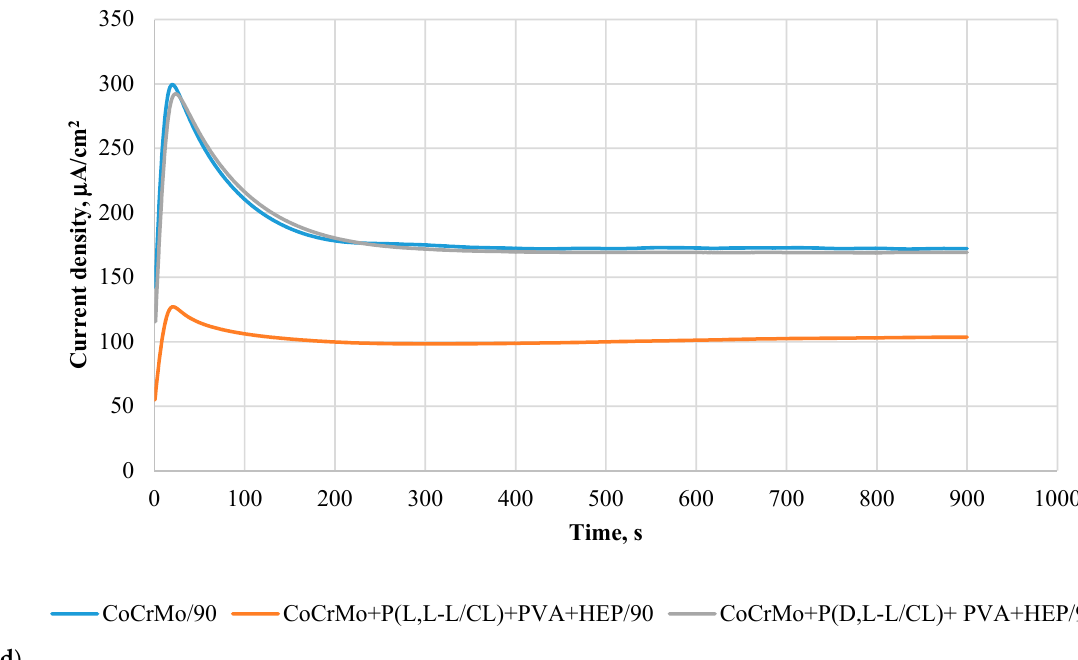
Figure 6. Comparison of exemplary potentiostatic curves for E = 800 mV for the tested variants. ( a ) In the initial state, ( b ) after 30 days; ( c ) after 60 days; ( d ) after 90 days, of exposure to artificial urine.